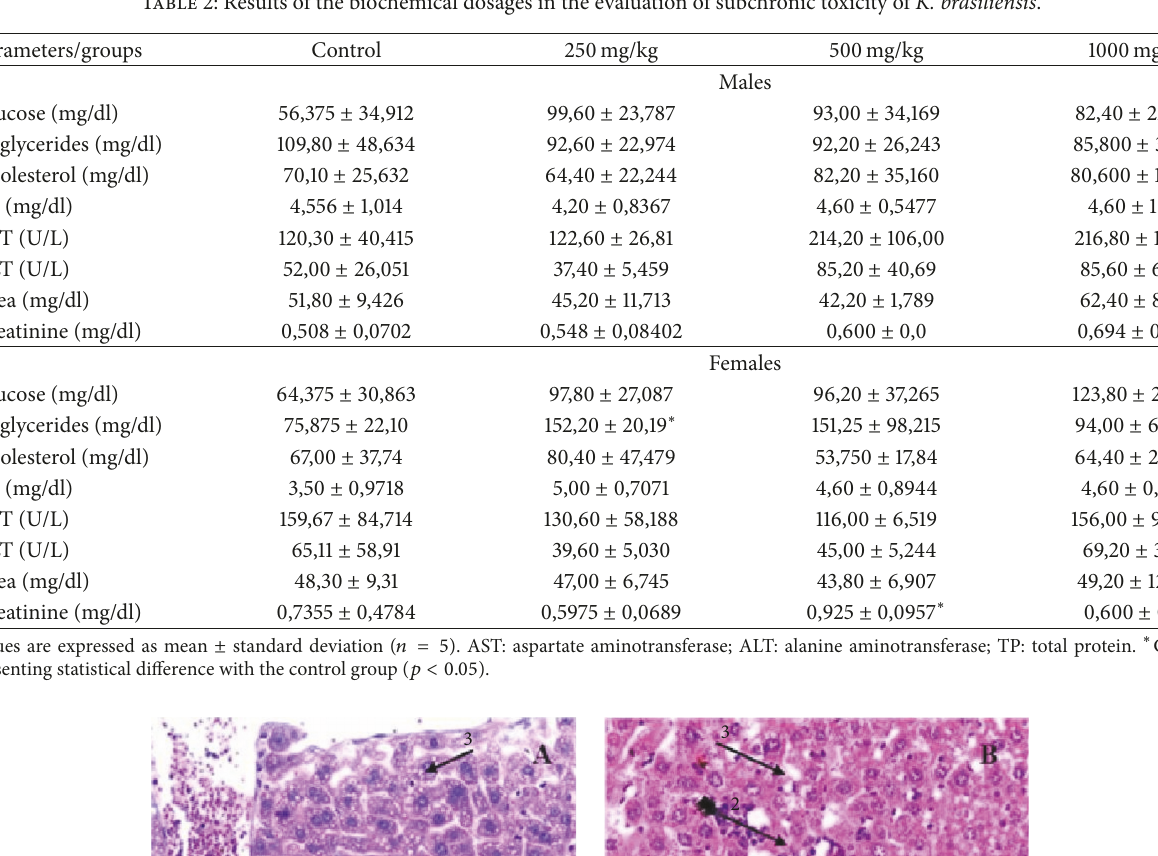
Table 2: Results of the biochemical dosages in the evaluation of subchronic toxicity of K. brasiliensis .